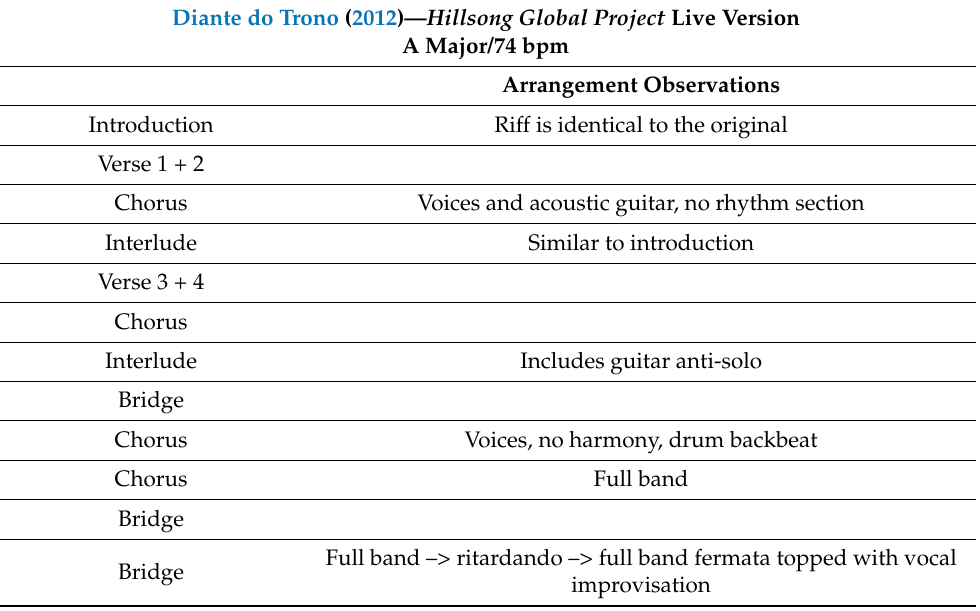
Table 5. Form and arrangement outline of Hillsong Brasil/Diante do Trono’s version of “Poder pra salvar”. Diante do Trono (2012)— Hillsong Global Project Live Version